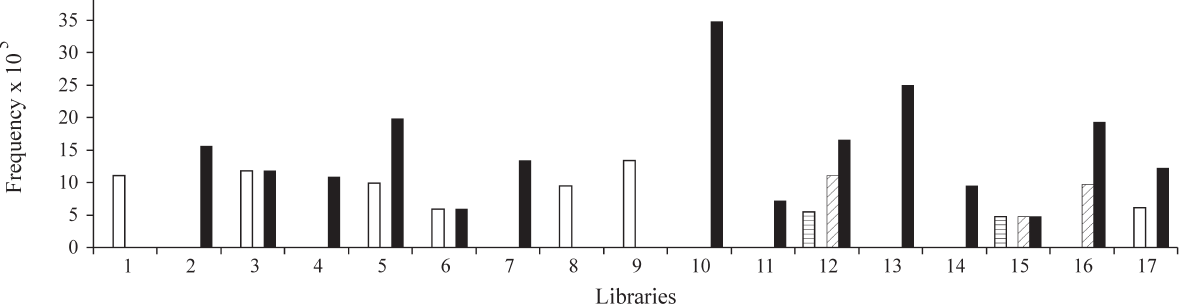
Figure1 -Expressionofmetalloproteasegenefamiliesinsugarcane.Thenumberofreadswerenormalizedtothetotalnumberofclonessequencedperli- brary. ATP-dependent metalloproteases, inverzincins, MMP-like proteins, Zincins. cDNA Libraries: 1. callus-tissue submitted to light/dark and tem- perature(4°Cand37°C)cyclostress( invitro );2.Etiolatedleaves( invitro plantlets)growinginvitro;3.Firstinternode;4.Flower(1cm-long);5.Flower (20 cm-long); 6. Flower stem (50 cm); 7. Lateral buds (plants); 8. Lateral buds of adult potted-plants (collected in liquid nitrogen); 9. Leaf-root transition zone (immature plants); 10. Leaf-root transition zone (plants); 11. Leaf roll (plants); 12. Plantlets without leafs but with roots infected with Gluconacetobacter diazotroficans ( in vitro ); 13. Same as item 12 but infected with Herbaspirillum rubri subespecies albicans ( in vitro ); 14. Roots of adult potted-plants (collected in liquid nitrogen); 15. Roots (plants); 16. Seeds in different stages of development; 17. Stem bark